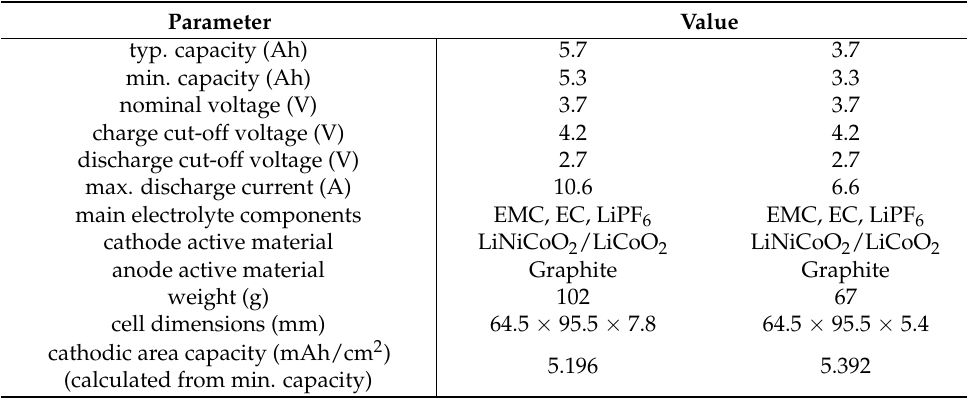
Table 1. Technical data of the investigated battery cells (SLPB776495 5.3 Ah, SLPB526495 3.3 Ah). EMC: ethyl methyl carbonate, DMC: dimethyl carbonate, EC: ethylene carbonate, LNCO: lithium nickel cobalt oxide, LCO: lithium nickel cobalt